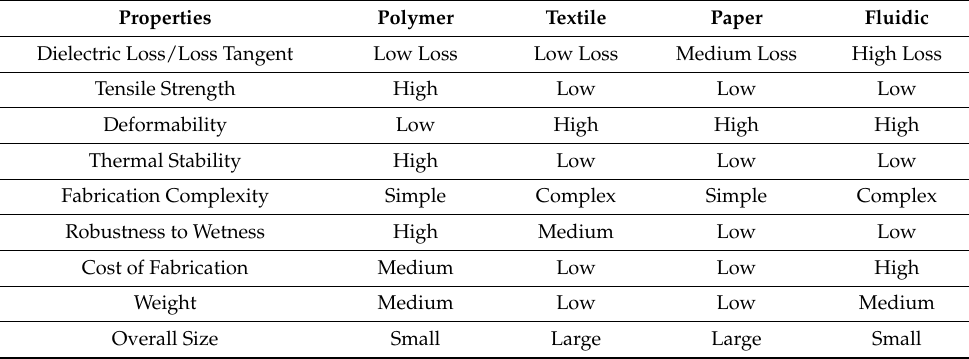
Table 3. Different flexible materials and their properties. Reprinted from ref.